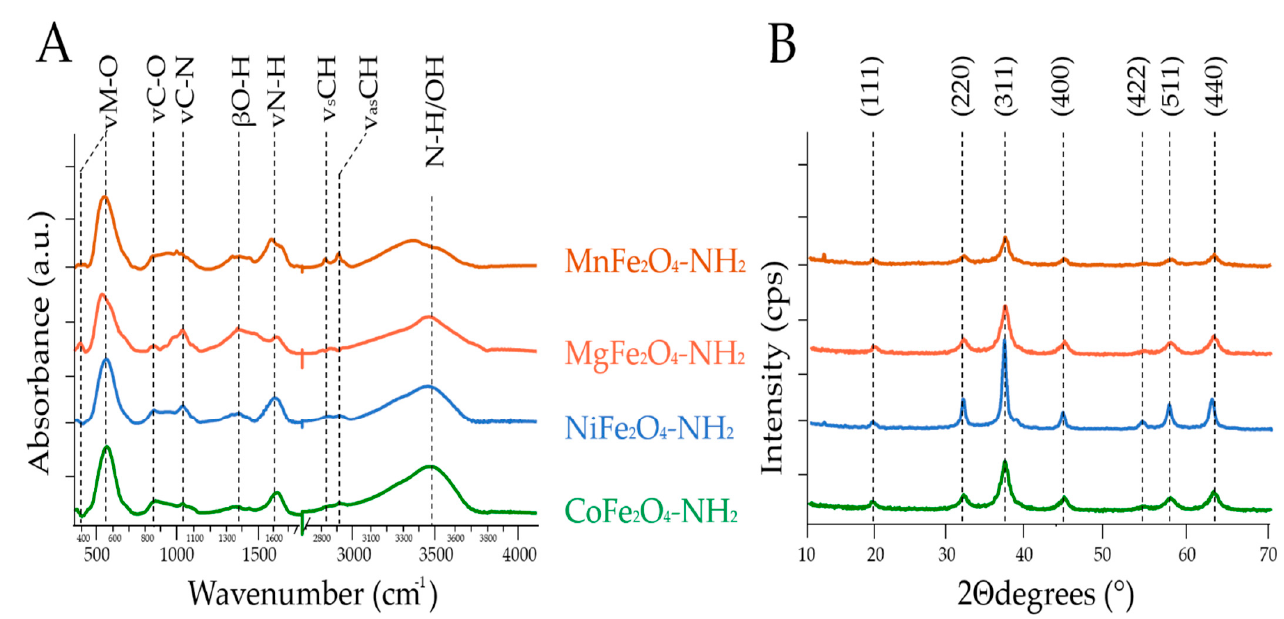
Figure 2. FTIR ( A ) and XRD ( B ) analysis of the synthetized nanoparticles.